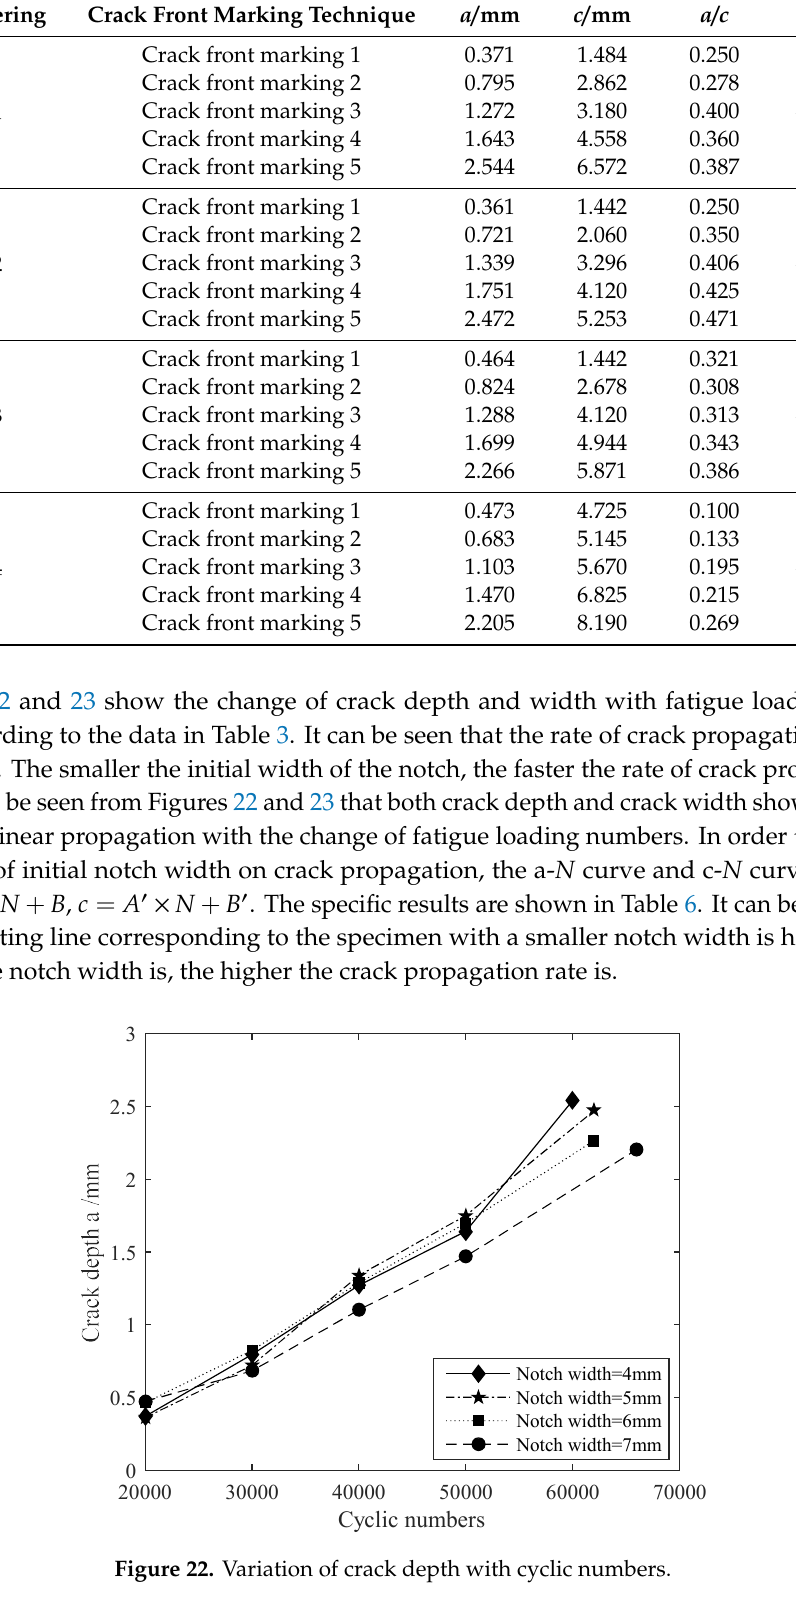
Table 5. Test data of steel wire crack propagation with notches of di ff erent widths.